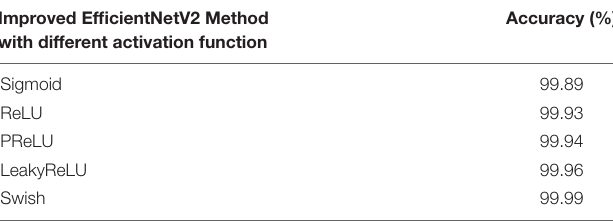
TABLE 3 | Comparative analysis of different activation functions.